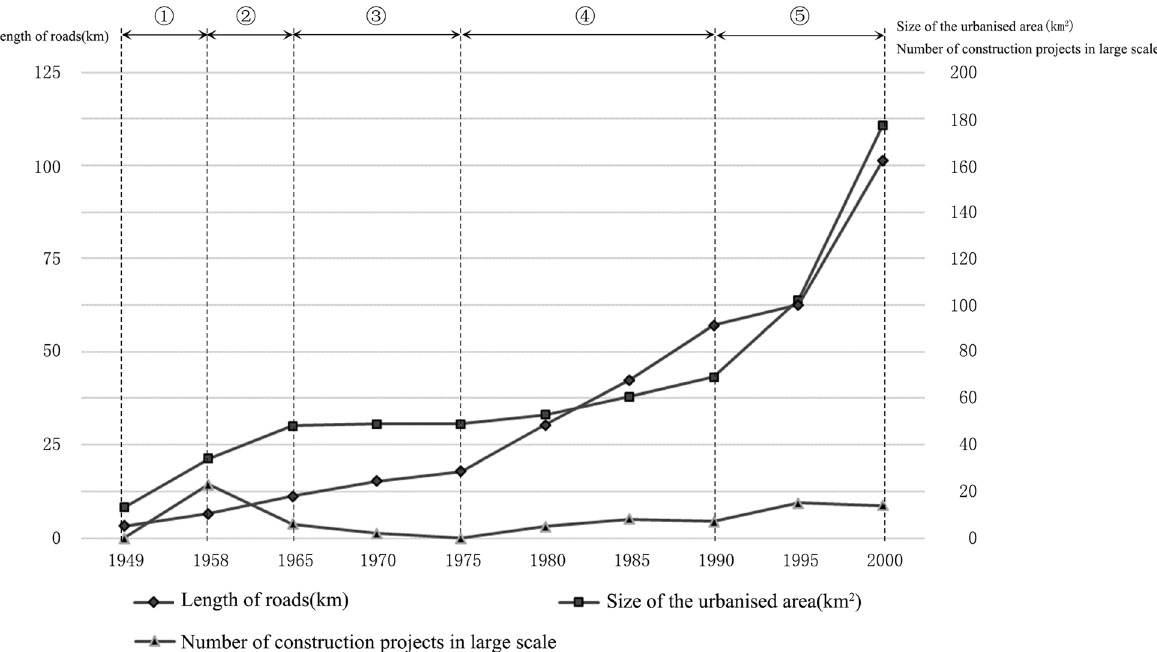
Fig. 1 Construction statistics of Hangzhou from the 1950s to the 1990s. In terms of built-up area, there were no statistical data for the years 1958, 1965, 1970 and 1975. Therefore, the data in the chart were calculated by the authors according to historical maps. In terms of the length of the urban road, this study calculates the total length of the high-grade road with a width of more than 3.5 m. In addition, due to the change in statistical methods and dimensions, the relevant data after 1995 are only for reference (Source: the authors. Data are from the Hangzhou